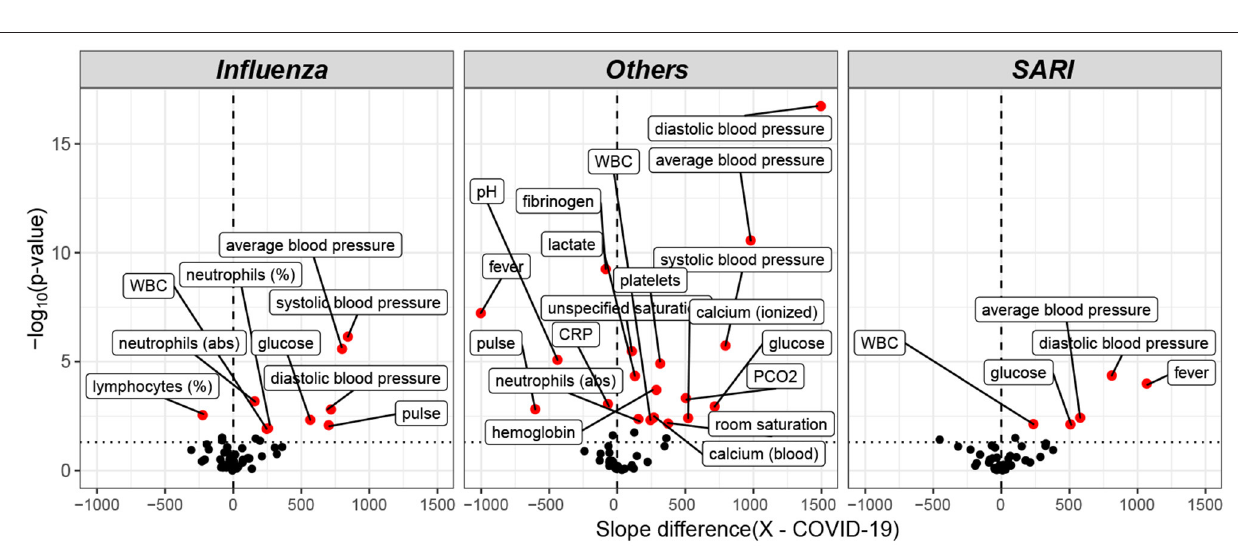
FIGURE 5 | Volcano plot of pairwise post hoc analysis of patients trajectory of COVID-19, influenza, SARI, and others for each lab tests. The level of significance is shown vs. the effect size, namely the slope difference (x—COVID-19). The most highly significant result was for average blood pressure, as seen at the left window, which refers to all influenza-COVID-19 comparisons, and at the right window, which refers to all SARI-COVID-19 comparisons. Trends for WBC, glucose, and diastolic blood pressure for COVID-19 patients were found to be different from both influenza and